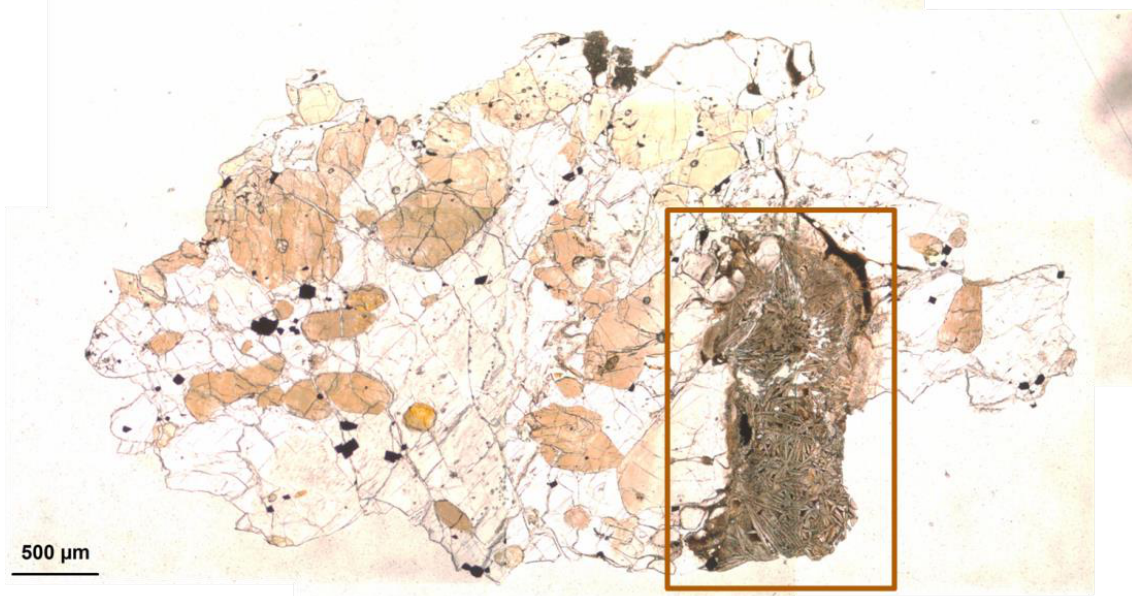
Figure 3. Thin section of ALH-77005 in plane polarized light. The studied area by FTIR spectroscopy is marked by rectangle, where the strong putative microbially mediated alteration was